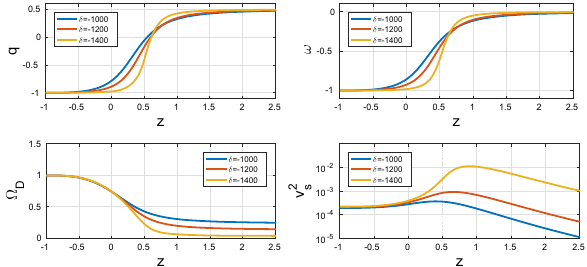
Fig. 1 q , (cid:7) D ( z ) , w and v 2 s ( z ) versus z for some values of δ . Here, (cid:7)